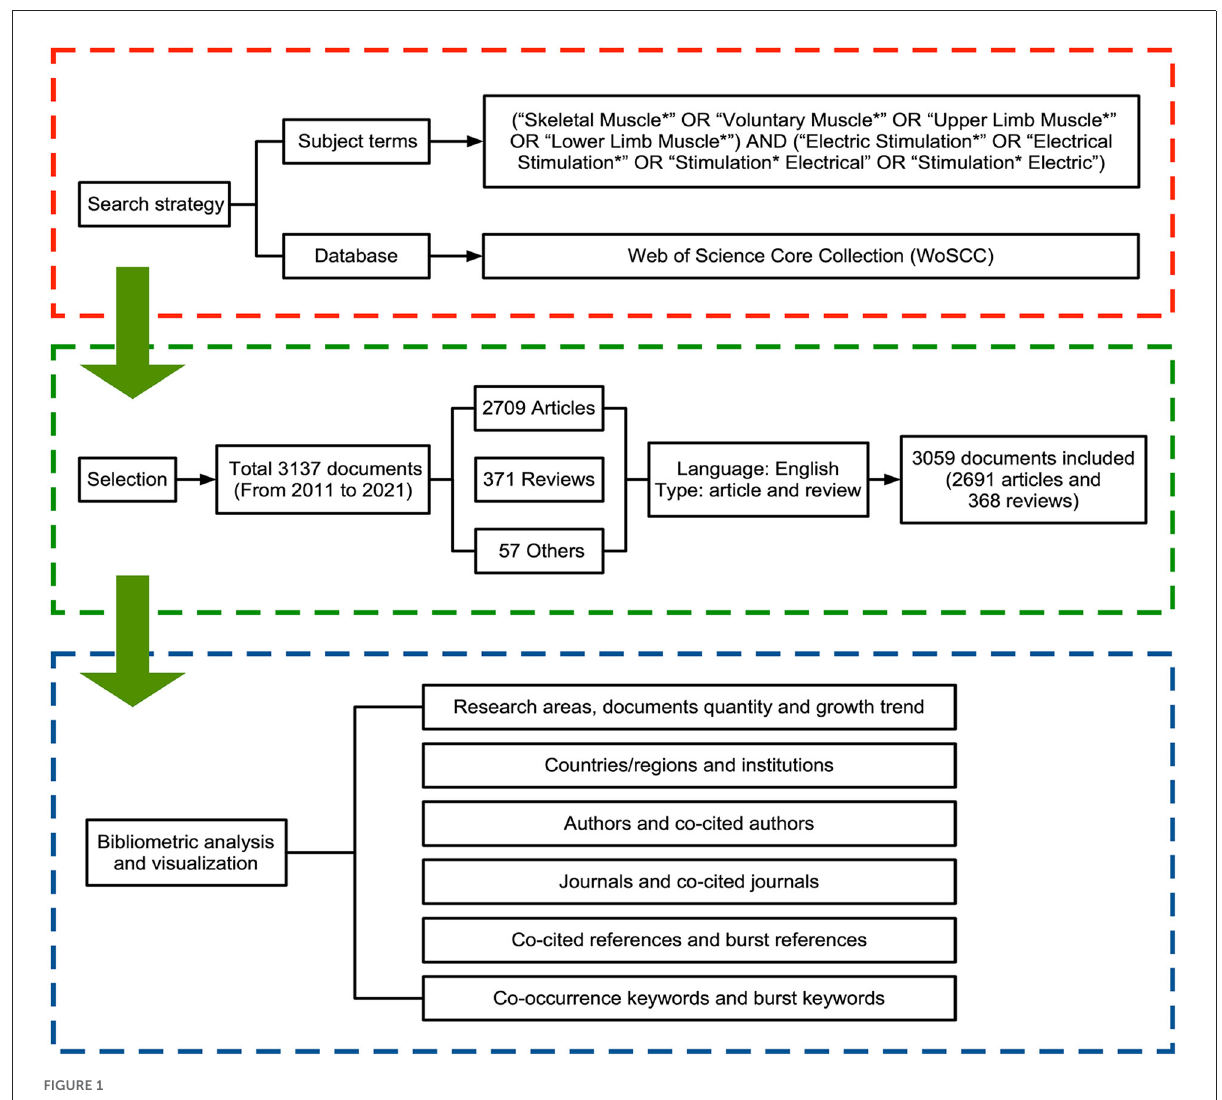
FIGURE1 Flow chart of bibliometric